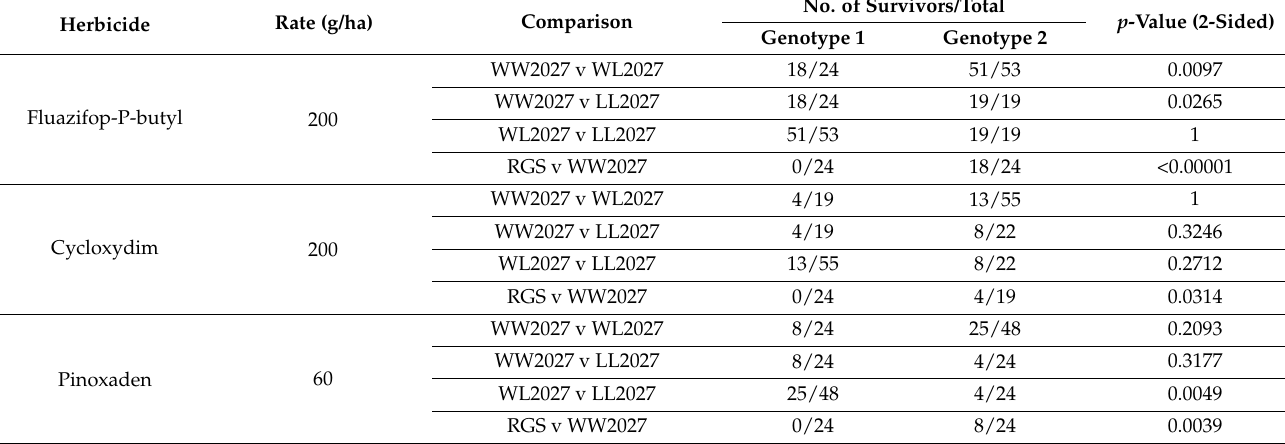
Table 2. Correlation between plant genotypes at ACCase codon 2027 and survivorship at single rates of three ACCase- inhibiting